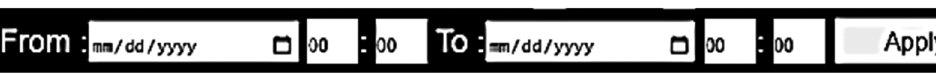
Figure 5: Time fi lter period input example.